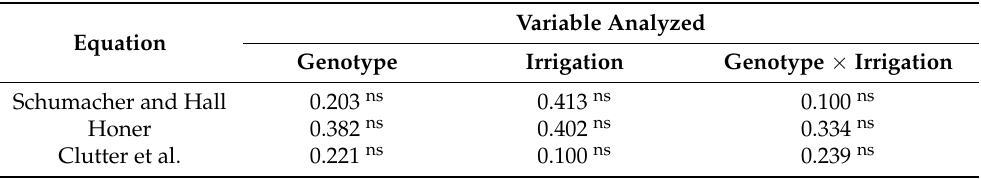
Table 1. Statistical significance ( p -value) of genotypes, irrigation, and their interaction on selected volume equations (ns, not significant).